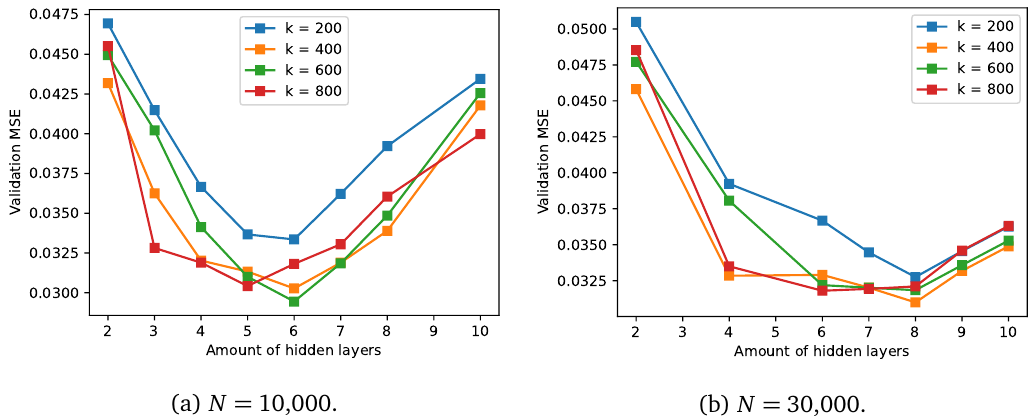
Figure 1: Validation MSE at the end of the training period for different amounts of hidden layers, neurons per layer and training data size